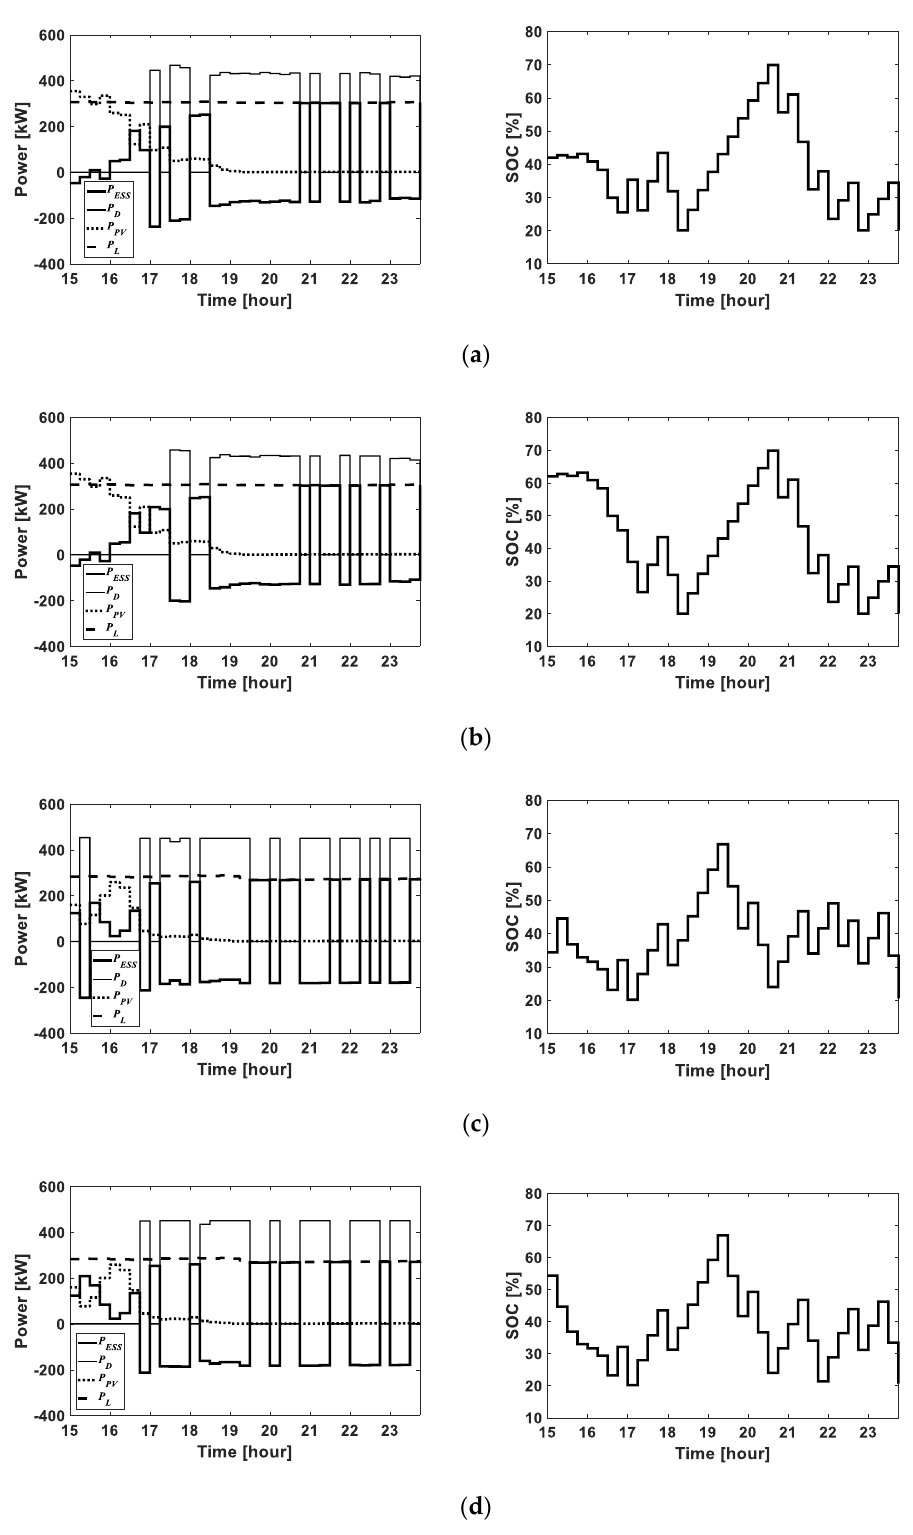
Figure 7. Simulation results of output power and SOC: ( a ) Case 1; ( b ) Case 2; ( c ) Case 3; ( d ) Case 4.